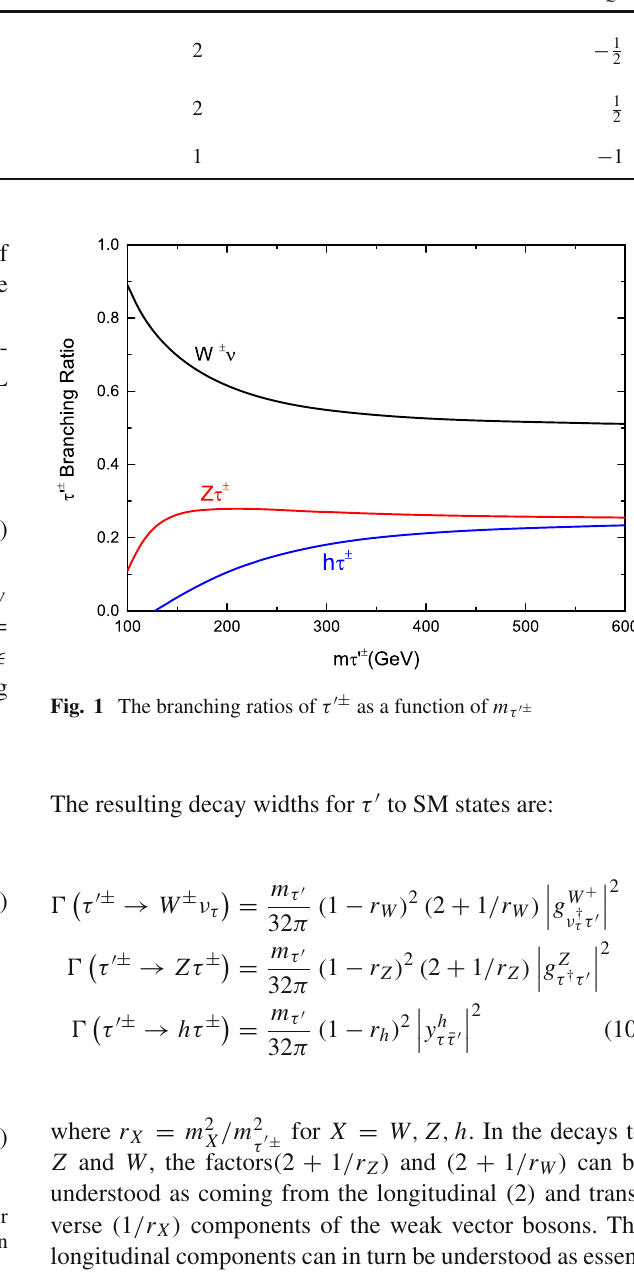
Table 1 The relevant particle fields and their SM quantum numbers in Eq. (2) 2-Component field